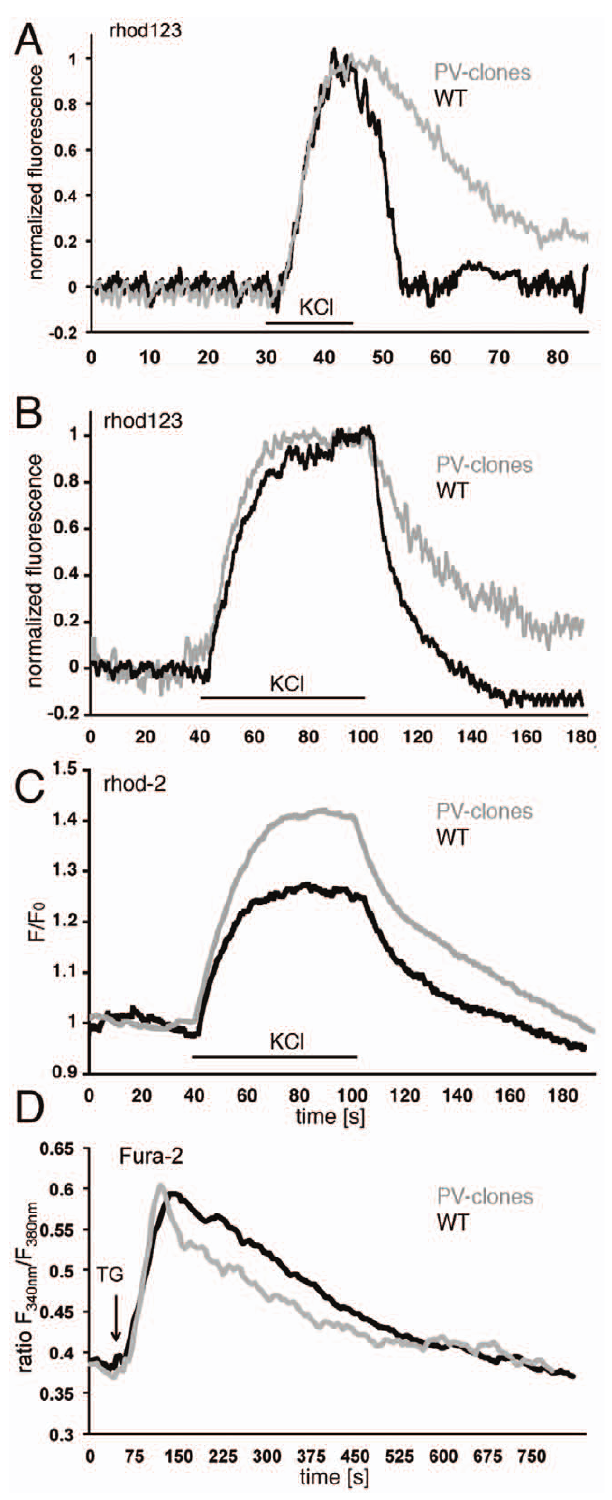
Figure 4. Effect of KCl-induced depolarization and thapsigar- gin treatment in C2C12 WT and PV-clones on mitochondrial membrane potential, [Ca 2 + ] m and [Ca 2 + ] c . A) Representative (normalized) traces of rhod123-loaded C2C12 cells (WT, black line and PV-clone, gray line) exposed to nominally 100 mM KCl for 15 s starting at 30 s. Higher values indicate a decrease in intramitochondrial membrane potential ( Dy m ). The average basal fluorescence